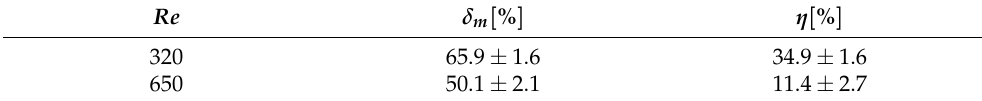
Figure 5. Numerical time signal of the mixing degree at Y = − 25 for ( a ) Re = 320 and ( b ) Re = 650. Table 1. Numerical values of the mixing degree and reaction yield at Y = − 25.